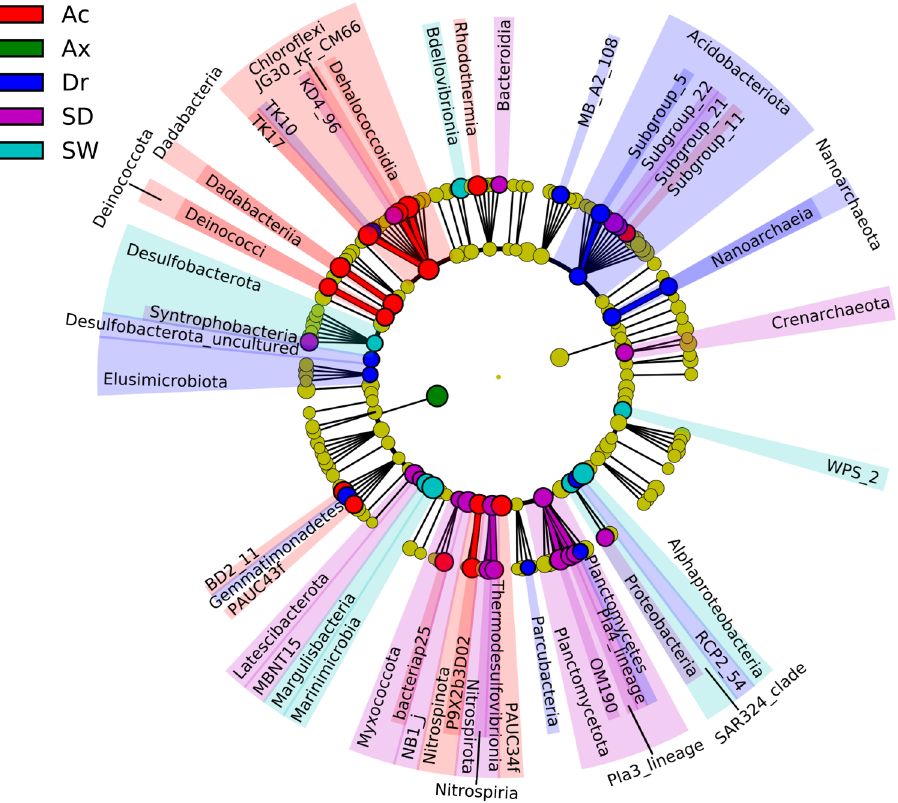
Figure 4. The linear discriminant analysis (LDA) effect size (LEFSe) analysis. Taxonomic representation of statistically and biologically consistent differences among Ap. caissara (Ac), Ax. corrugata (Ax), D. reticulatum (Dr), seawater (SW), and sediment